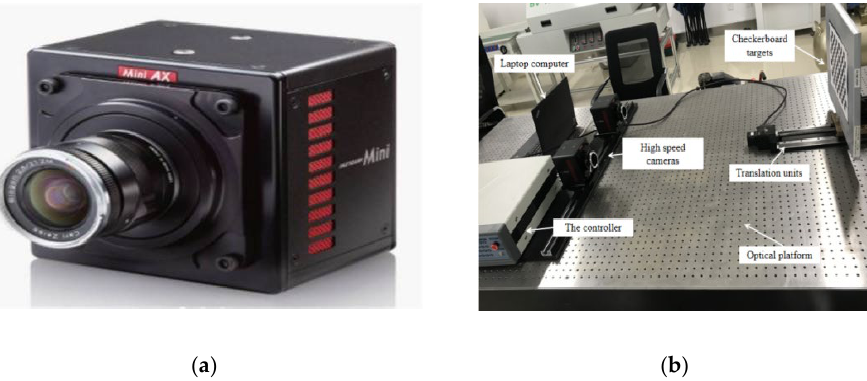
10 of 24 Figure 3. Predictive model flowchart. 3. Experiments and Results 3.1. Expeimental Equipment In order to verify the feasibility of the model and the performance of the proposed calibration method, a series of experiments were conducted. An experimental system con-